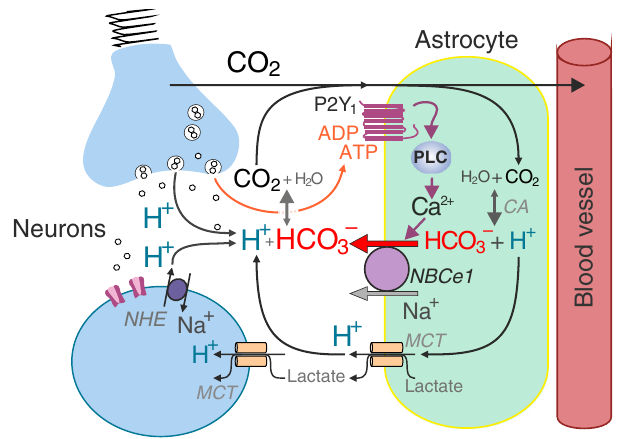
Fig. 8 Brain CO 2 /H + cycle. Schematic drawing of the neurovascular unit illustrating the proposed cellular mechanisms contributing to the maintenance of brain extracellular pH homeostasis. We hypothesise that extracellular acid loads associated with enhanced neuronal activity are effectively buffered by HCO 3 − released by astrocytes via the mechanism described in this study. CA, carbonic anhydrase, PLC, phospholipase